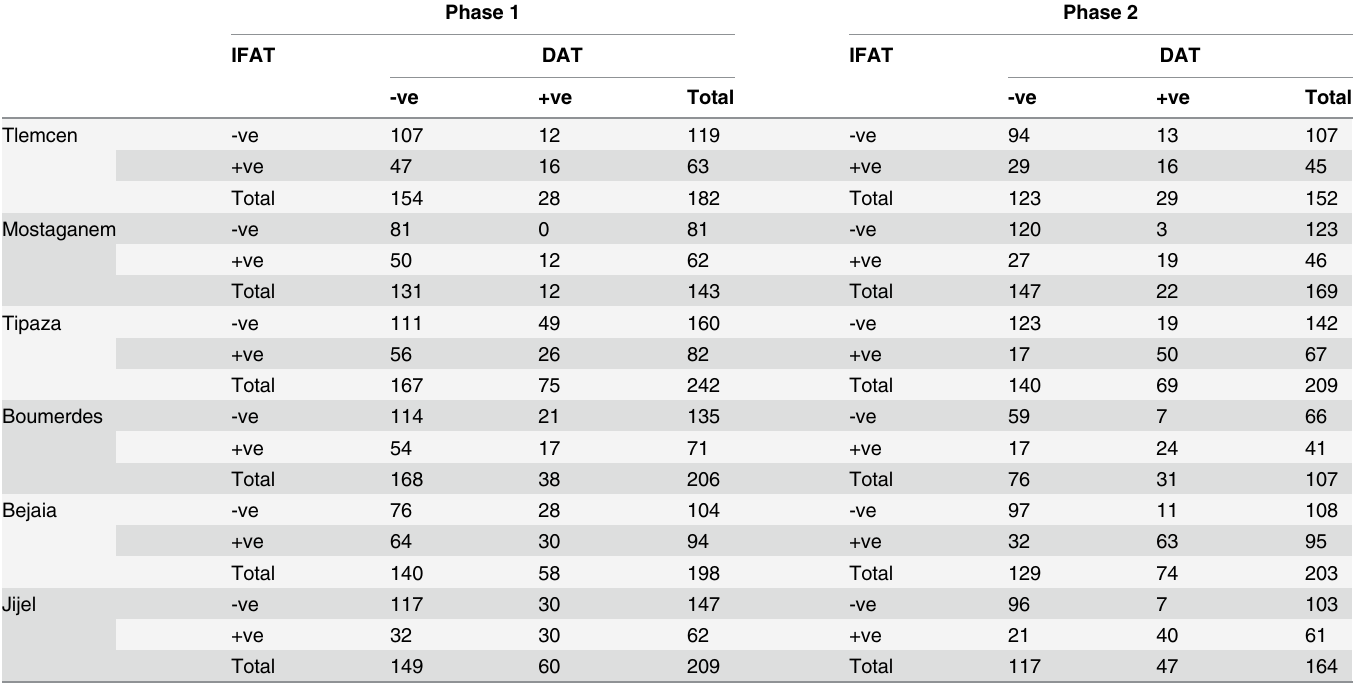
Table 2. Contingency tables per locality per sampling period with positive (+ve) and negative (-ve) results in IFAT and DAT. Phase 1 Phase